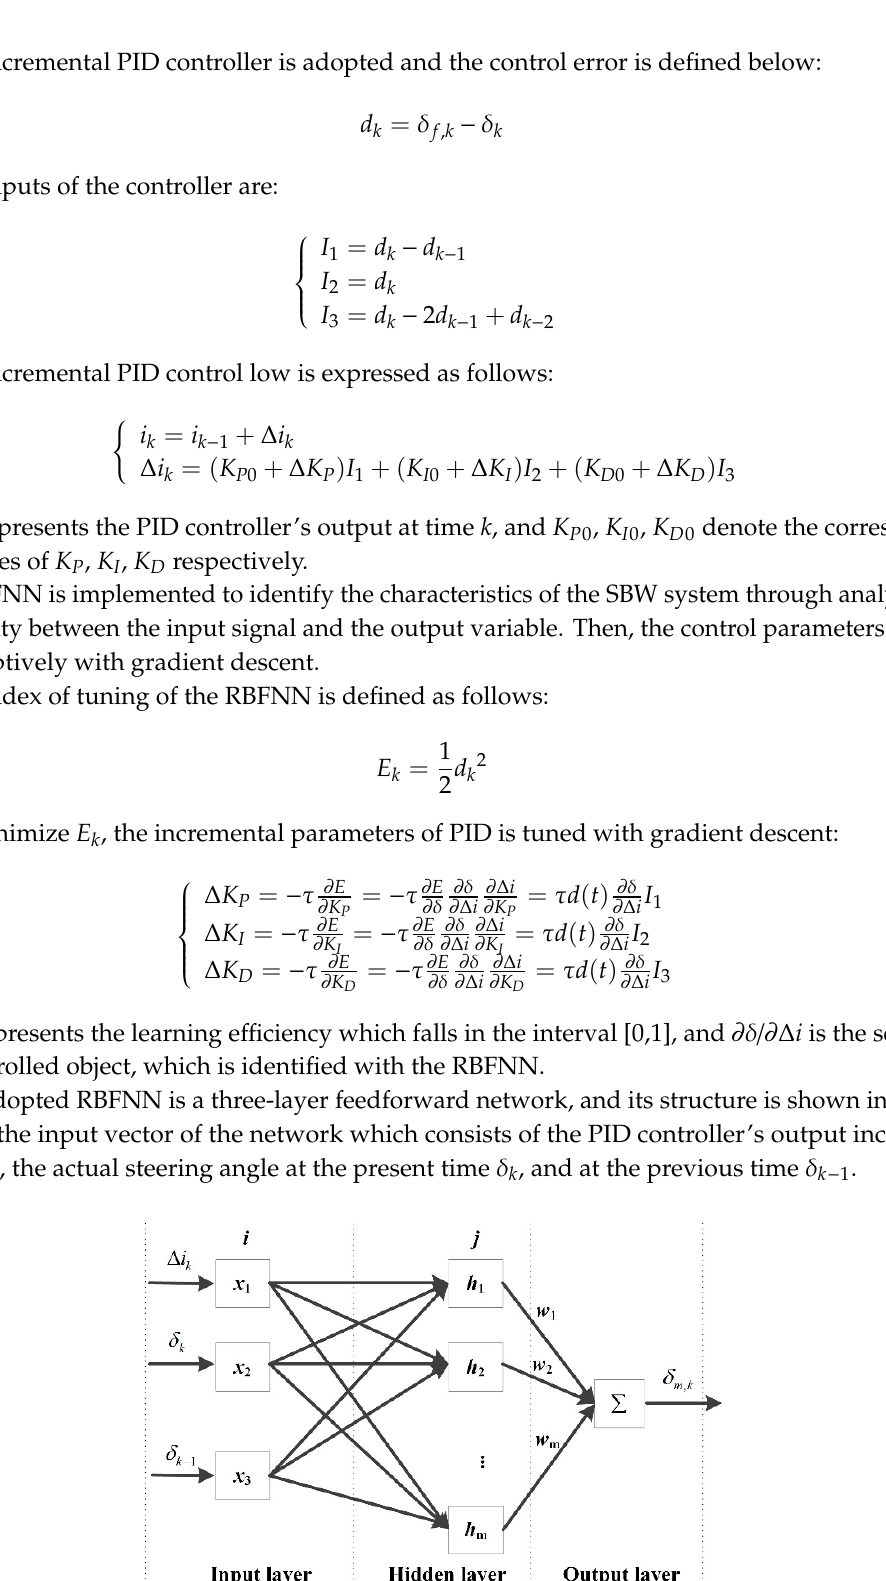
Table 4. Vehicle model parameters. Symbol